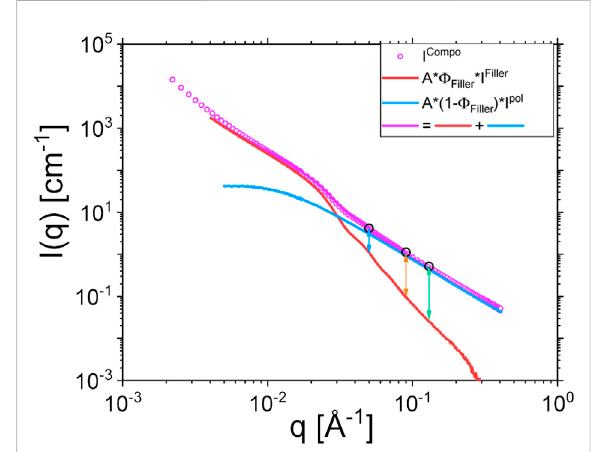
FIGURE 4 Reproduction of composite scattering signal following Eq. 3. The example is given for sample II. Vertical arrows indicate the scattering vector moduli at which the NSE measurements are performed. The extracted fi ller scattering using the experimental polymer scattering is congruent with independent SAXS scattering experiments. The same details of the silica particle form factor and intraparticle structure factor are visible in the range 0.03 < q < 0.06 Å − 1